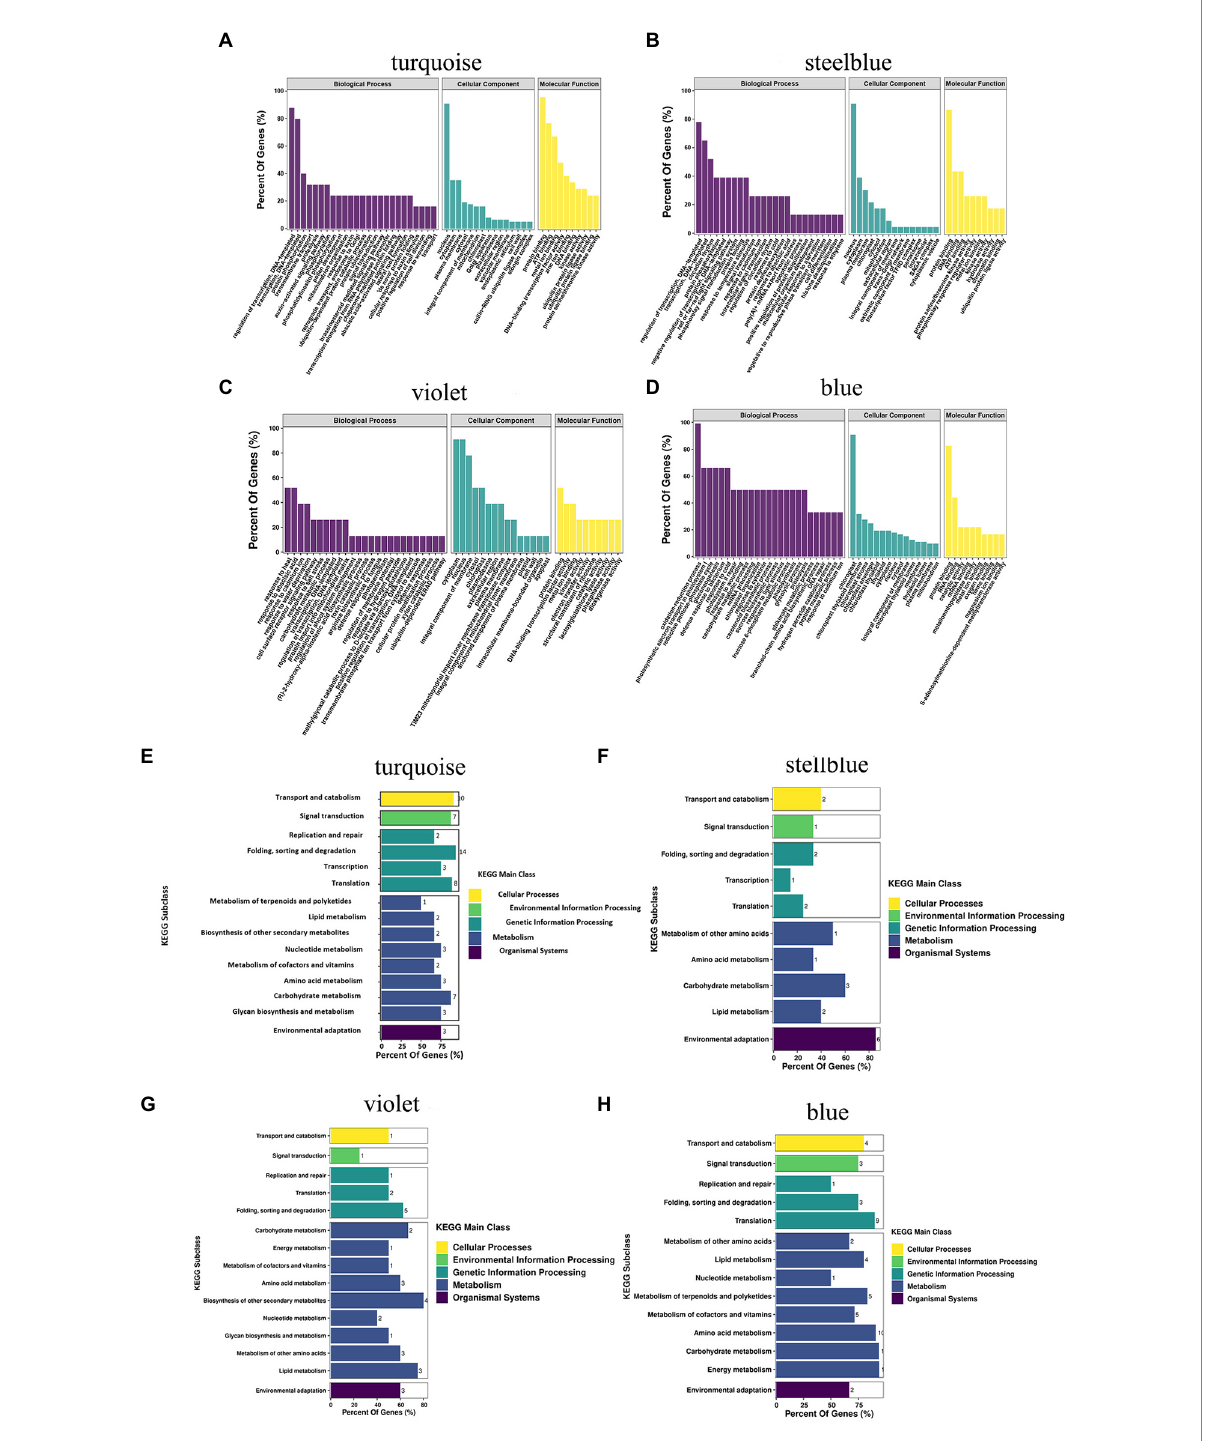
FIGURE 7 GO classification and putative KEGG pathways of specific modules related to drought resistance in Agropyron mongolicum. The GO classification and KEGG pathway of turquoise, steelblue, violet, and blue modules are represented by (A) , (B) , (C) , (D) , (E) , (F) , (G) , and (H) , respectively. GO, Gene Ontology; KEGG, Kyoto Encyclopedia of Genes and